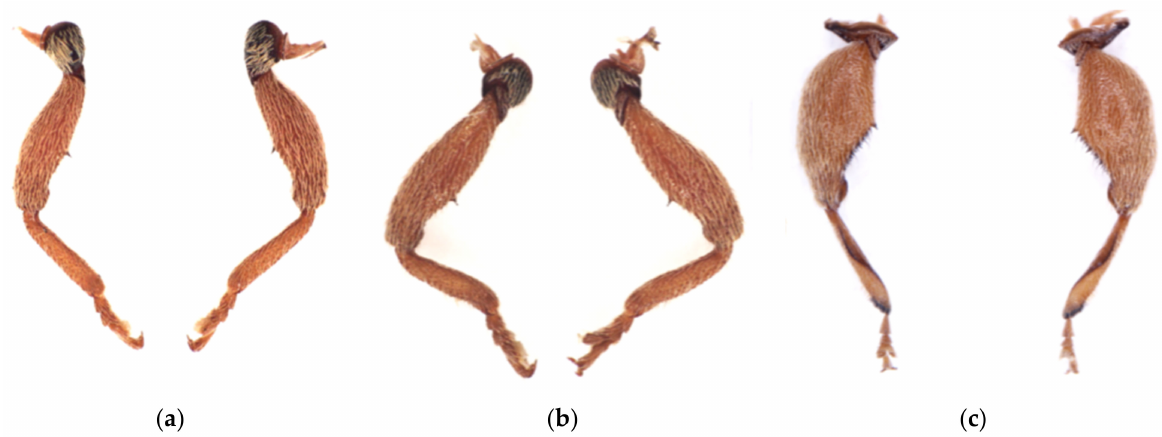
Figure 6. Legs of Rhynchaenus maculosus . ( a ) Forelegs with a single spine on the ventral side of the femur; ( b ) mid-legs with a single spine on the ventral side of the femur; ( c ) hindlegs with a developed femur armed with a row of spines on the ventral